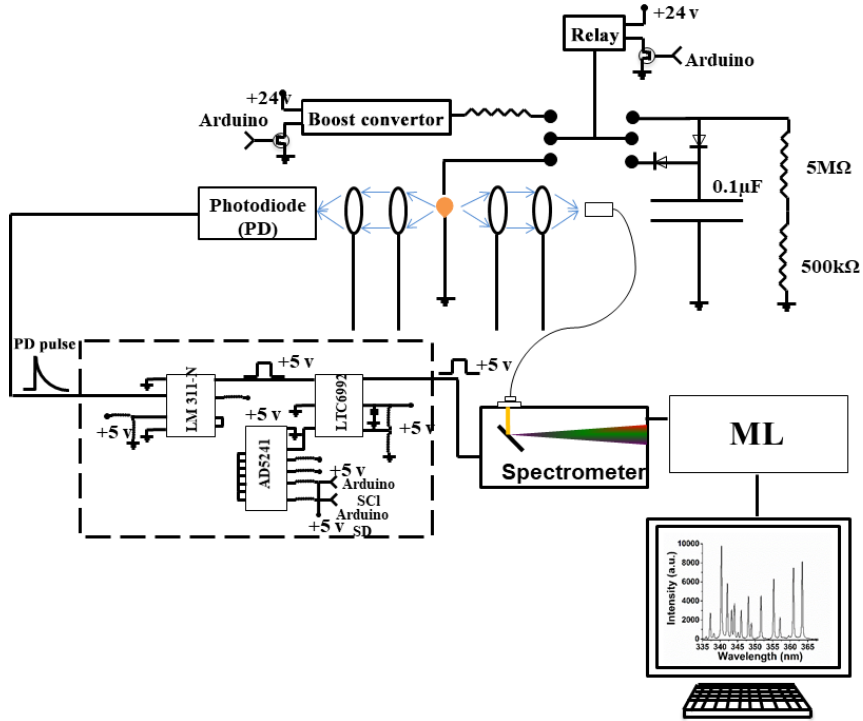
Figure 1. Schematic of the developed spark emission spectroscopy.